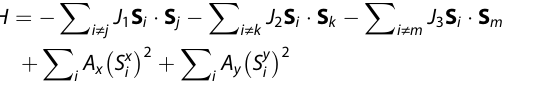
Δ Δ Δ = U – J parameter. When U 1 , 2 , and 3 ) as the U eff eff is less than